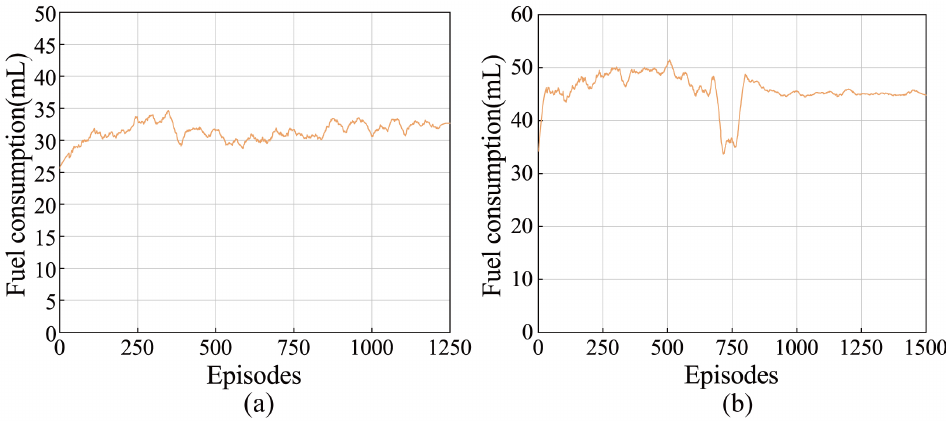
Figure 14. Fuel consumption of agent on different interaction prediction models. ( a ) Medium coarse gravel. ( b ) Small coarse grave.